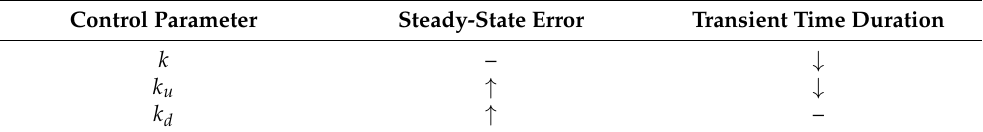
Figure 11. Results of numerical experiments. Error signal between system output and reference command e ( t ) . The final part of a long-term simulation. Table 2. Effects of the controller parameters on the dynamics of the closed-loop system (data obtained from numerical experimentation by independently increasing each control